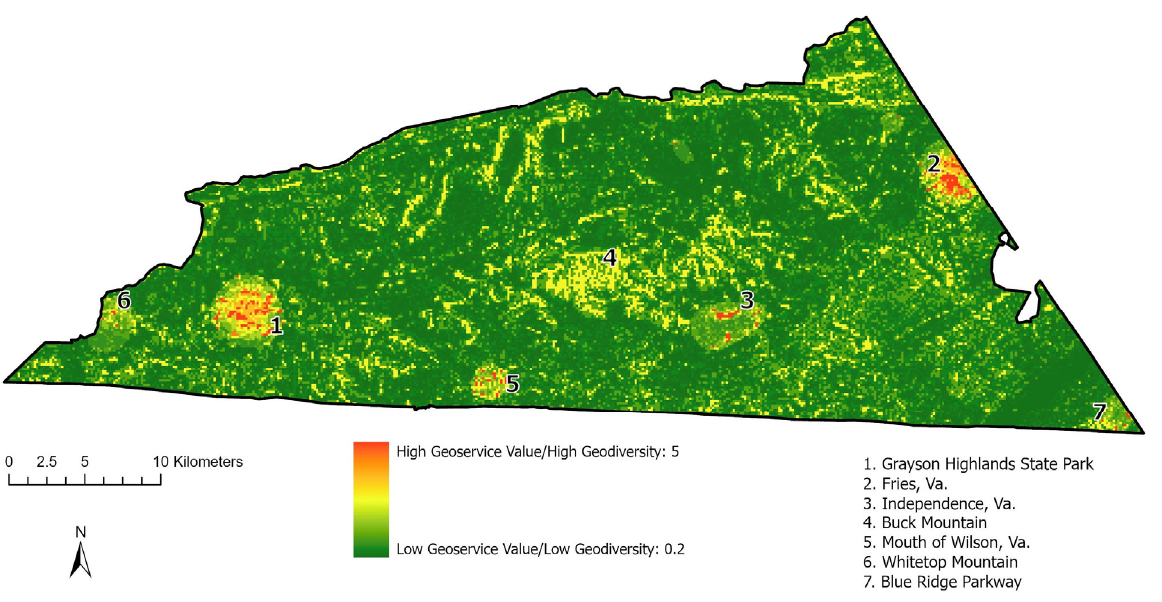
Figure 7. Geodiversity–geosystem services value hotspot map visualizes areas with high clusters of geosystem services marker and areas characterized by high quantitative geodiversity. Numbers refer to major landmarks.